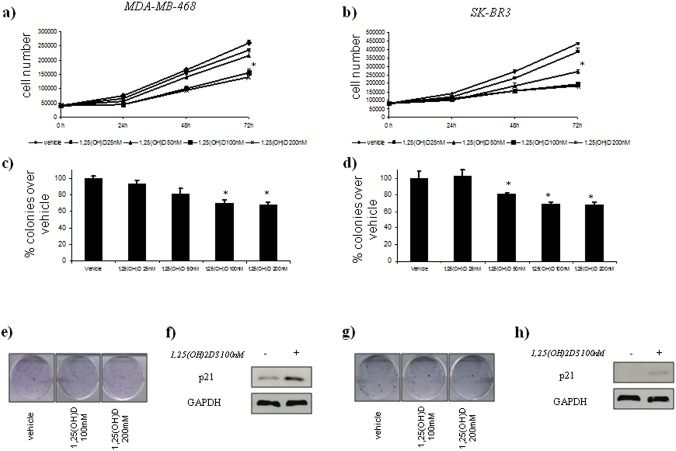
Vitamin D anticancer effects in vitro on ER(–) breast cell lines with AA Cdx2 status.Time-dependent growth curves of MDA-MB-468 (a) and SK-BR3 (b) cells in the absence or in the presence of different doses of 1,25(OH)2D3 (25–200 nM). Histograms (c and d) showing average colony percentage over vehicle from duplicate experiments at 10–21 days from seeding. Bars indicate the average of three independent experiments. * statistics: p < 0.05. Representative micrographs of colonies formed by MDA-MB-468 (e) and SK-BR3 (g) cells treated with 1,25(OH)2D3 as indicated. Representative western blot analysis of whole cell lysates obtained from MDA-MB-468 (e) and SK-BR3 (f) cells treated as suggested and stained with the indicated antibodies. GAPDH staining was used as a loading control.